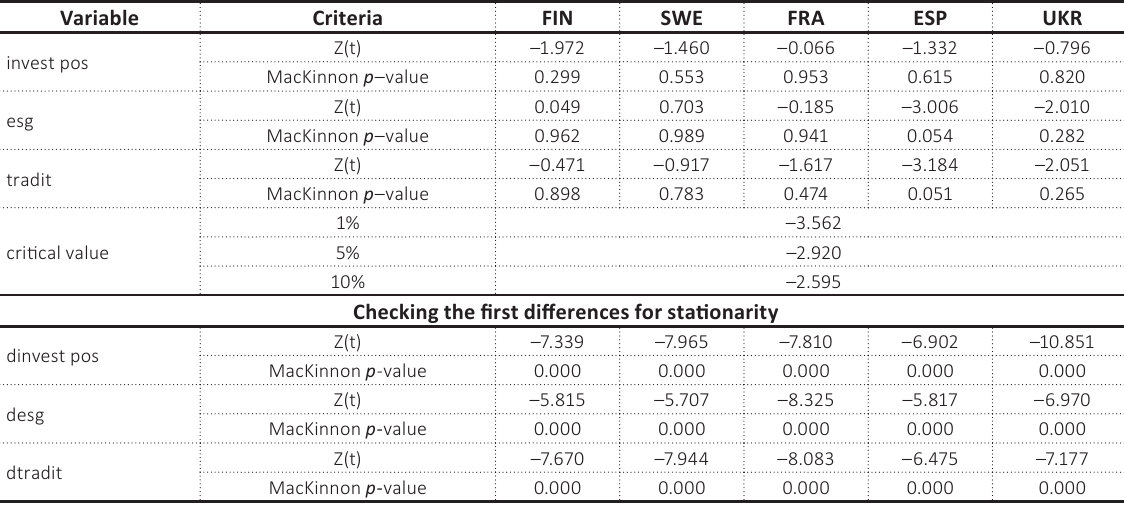
Table 9. Checking time series for stationarity using the Dickey-Fuller test